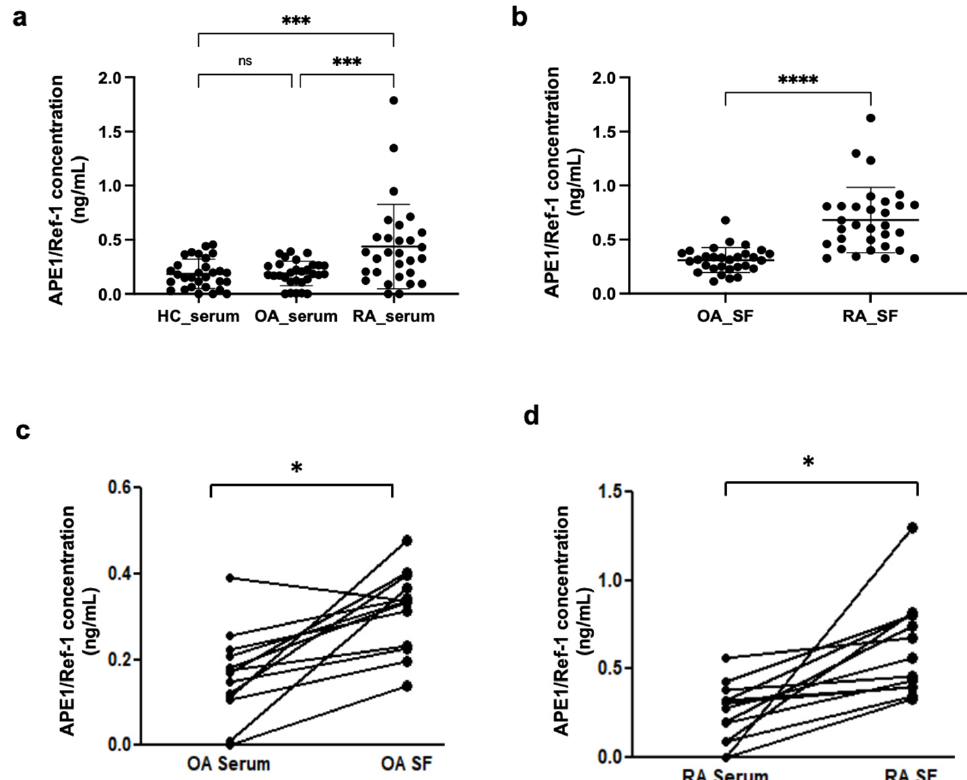
Figure 1. The concentration of apurinic/apyrimidinic endonuclease 1/redox factor-1 (APE1/Ref-1) was increased in synovial fluid (SF) of rheumatoid arthritis (RA) patients. ( a ) The serum levels of APE1/Ref-1 in patients with RA ( n = 29) were significantly elevated compared to those of the healthy control (HC) ( n = 30) and osteoarthritis (OA) patient groups ( n = 30). ( b ) The RA patient group ( n = 31) had a significantly higher APE1/Ref-1 concentration in their SF than that of the OA patient group ( n = 30). Dot plots represent the mean; bars represent the SD. *** p < 0.001, **** p < 0.0001 vs. RA group based on one-way ANOVA analysis followed by Bonferroni’s multiple comparison test and unpaired t -test. ( c , d ) Significant correlations were found between serum and SF APE1/Ref-1 levels in paired OA samples ( n = 16) ( c ) and RA samples ( n = 13). ( d ) Statistical significance was